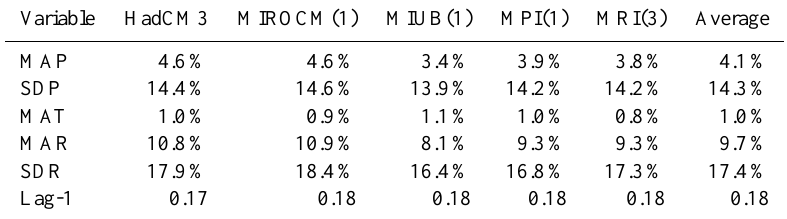
Table 5. Relative within-GCM uncertainty of mean and standard deviation of annual precipitation, mean annual temperature and mean, standard deviation and lag-1 serial correlation of annual runoff. Relative uncertainty is the standard deviation of the 100 replicate estimates as a percentage of the mean replicate estimate for each GCM during the period 1965–1994 (20C3M). The average of the 17 catchment relative uncertainty values is presented, except for lag-1 annual runoff which is the average of the 17 standard